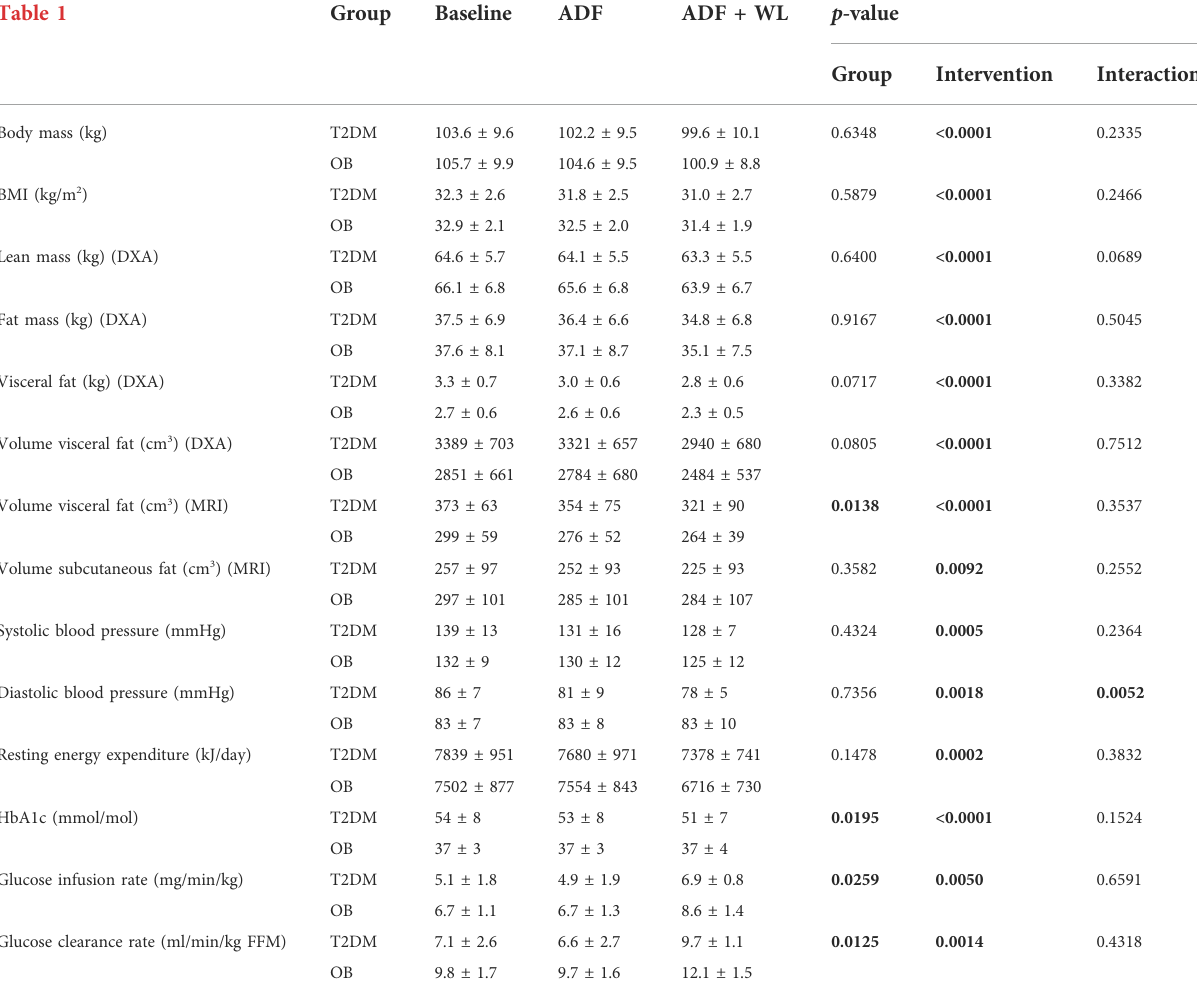
Table1:Twelvemaleswithobesityandtype2diabetes(T2DM)andelevenmaleswithobesity(OB)carriedout6weeksoffastingeveryotherday,i.e.frommidnightandcontinuedfor30 h until06.00thefollowingday.The fi rst3 weeksofthealternatedayfasting(ADF)thestudyparticipantshadadoubledietintakeoneatingdaystoavoidachangeinbodyweight.Duringthe following3 weeks, therewereno dietaryrestrictions,i.e.thestudy participants wereallowed tolosebodyweight(ADF + WL). The volumeof visceraland subcutaneousfatwasmeasured withMRI(1 cmsliceatthelevelofmidL3).Glucoseinfusionrates(GIR)andglucoseclearancerateswerederivedfromthe fi nal30 minofa120 mineuglycemic,hyperinsulinemic(80mu/ min/m 2 )clampperformedatBaselineandatADF(T2DMn,11;OBn,11),andinasubgroupatADF+WL(T2DMn,6;OBn,2).Theaverageoftwobaselineclampsperformed2 – 3weeks apartisreportedasthebaselinevalue. p -valuesarederivedfromrepeatedmeasuresANOVA(ormixedmodelincaseofmissingdataatrandom)andindicatethedifferencebetweengroups (Group), the difference with the intervention across groups (Intervention) and group dependent effects of the intervention (Interaction), when p < 0.05. Data are shown as mean ± SD. Bold values indicate p <